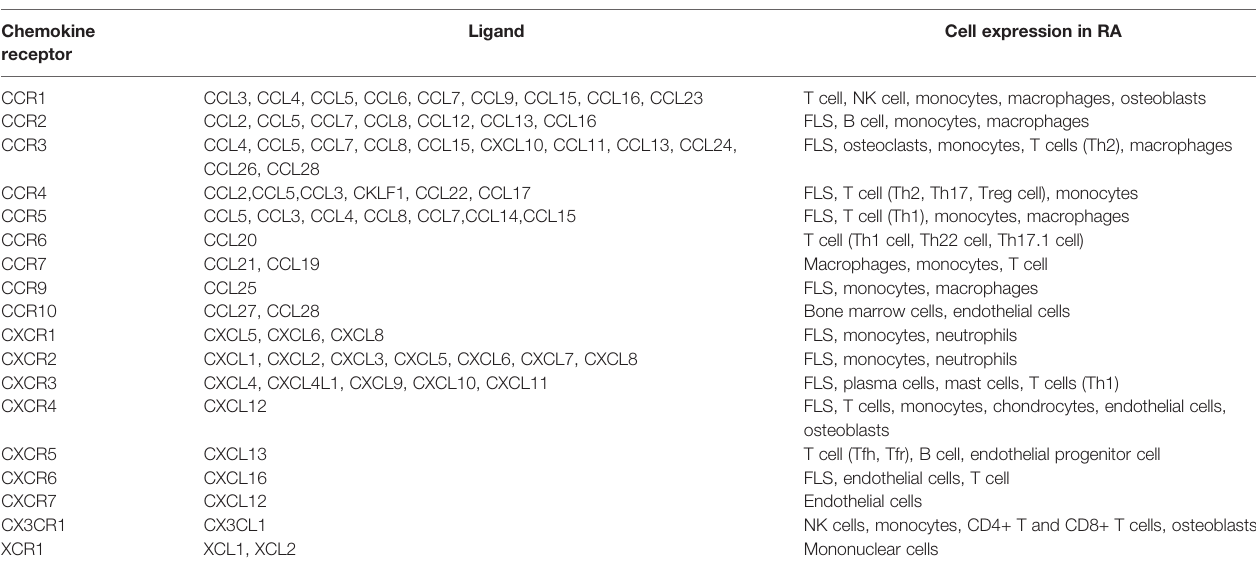
TABLE 1 | Chemokine receptors and their